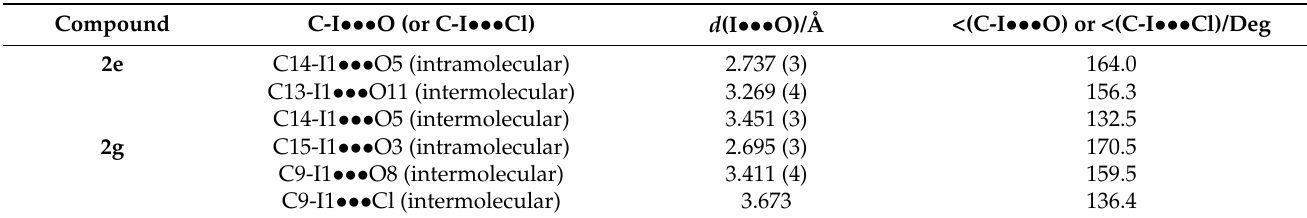
Table 2. Crystallographic parameters of the intra- and intermolecular XB interactions in the crystals of iodonium ylides 2e and 2g . Compound